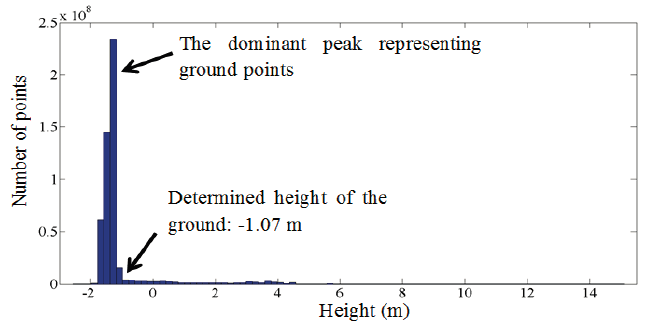
Figure 3. Height histogram of a sample